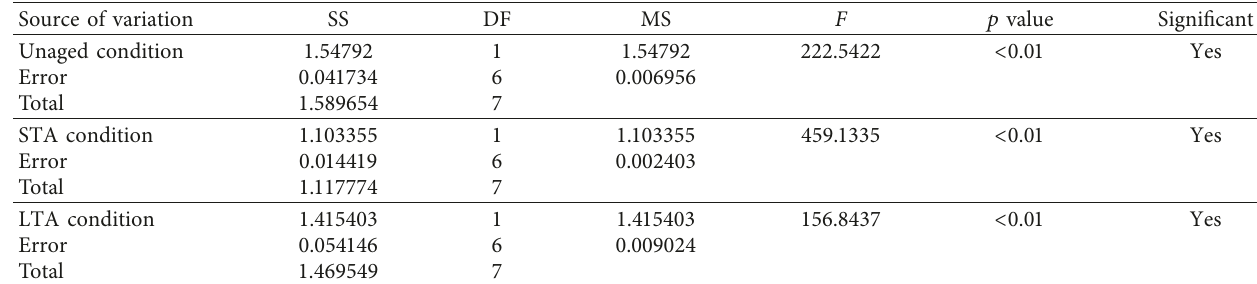
Table 10: One-way ANOVA on effects of compatibility ratio of PG-76 binder with limestone and granite aggregate. Source of